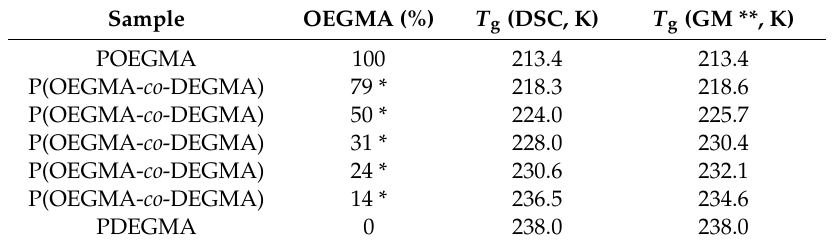
Figure 9. Glass transition temperature ( T g ) as a function of mol fraction of DEGMA in the copolymer ( R 2 = 0.9613). Table 1. Glass transition temperatures for statistical copolymers poly(OEGMA- co -DEGMA). Sample